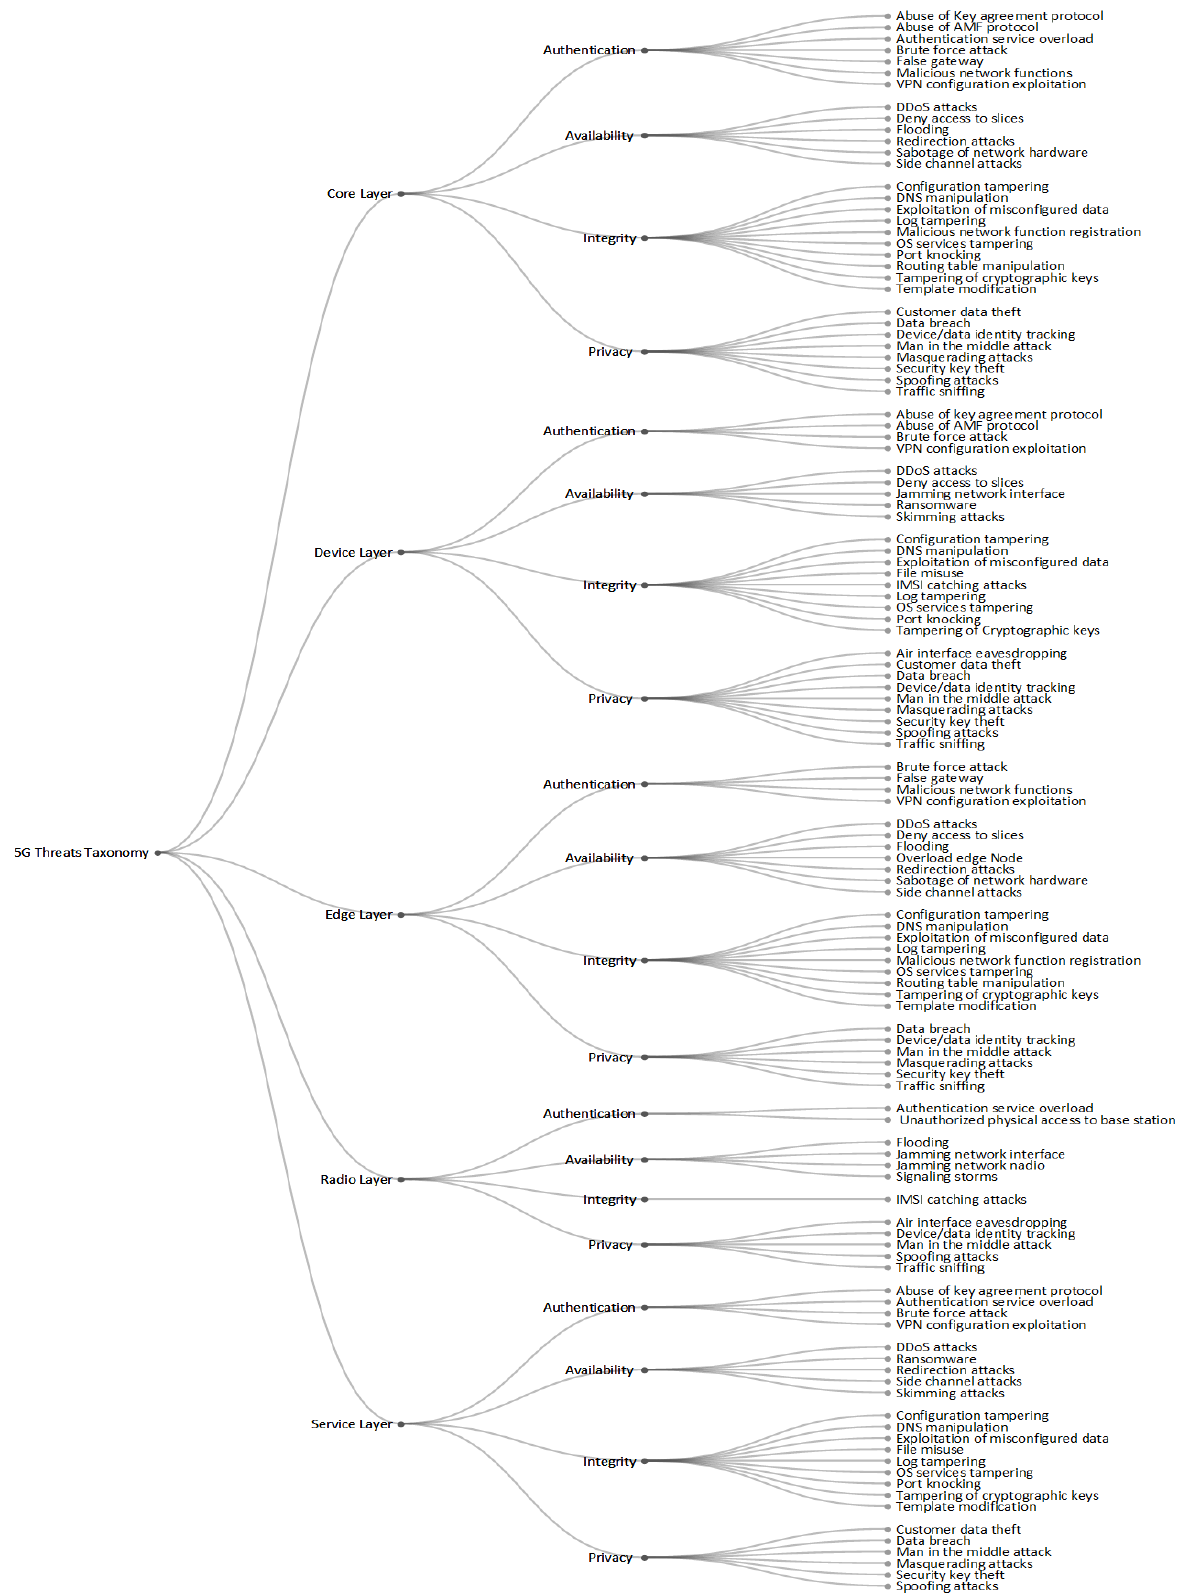
Figure 4. Taxonomy of 5G threat mapped with